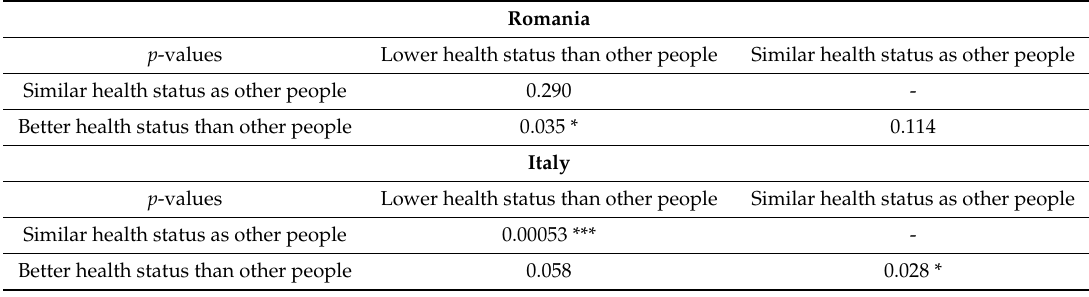
Table 8. Post–hoc test for health status: Optimism index 1.